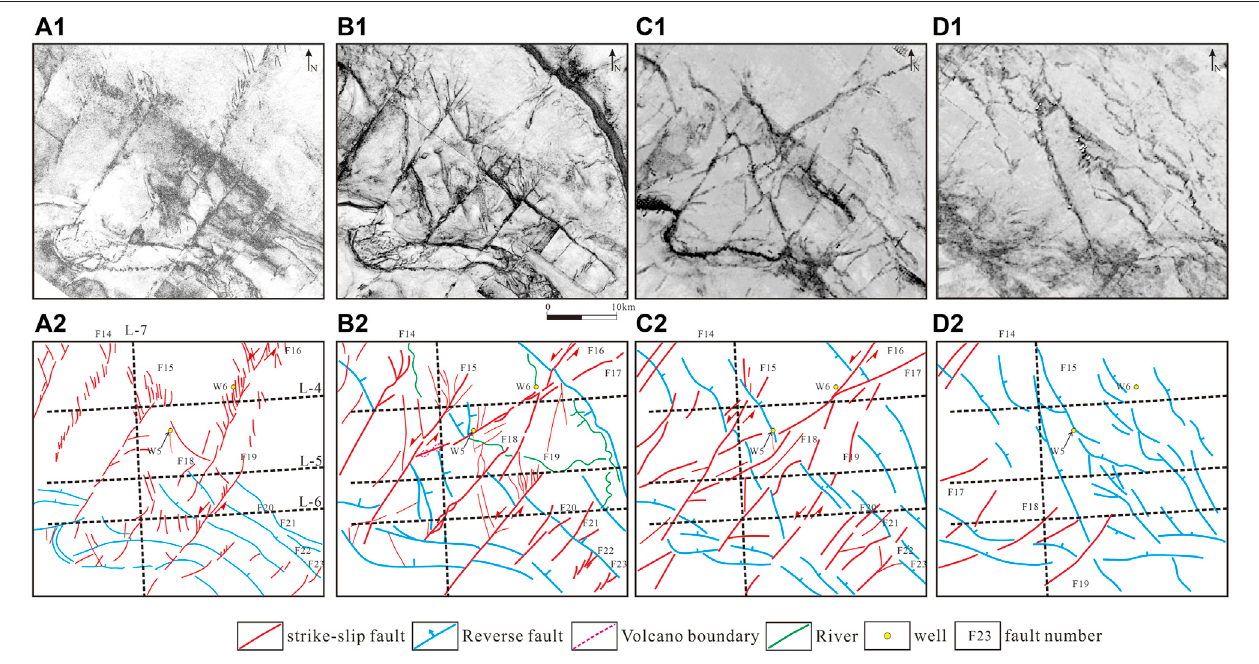
FIGURE11| Uninterpreted coherenceslices(top images in A1 – D1 ;forlocation,see Figure 5 )and interpreted fault systems (bottom imagesin A2 – D2 )ofdifferent seismicre fl ection surfaces oftheTazhong uplift: (A1) Tsre fl ectionsurface(bottom oftheSilurian), (A2) To3re fl ection surface(bottom oftheUpperOrdovician),(A3)T Є 3 re fl ection surface (bottom of the Upper Cambrian), and (A4) T Є 1 re fl ection surface (bottom of the Lower Cambrian).